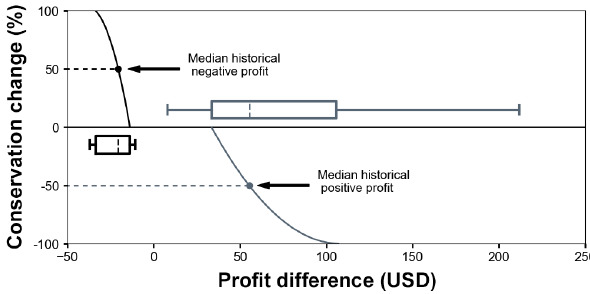
Figure 4. Example of percent conservation change for δC profit and δC futures . Gray curves indicate negative percent change (de- crease in conservation land), and black curves indicate positive per- cent change (increase in conservation